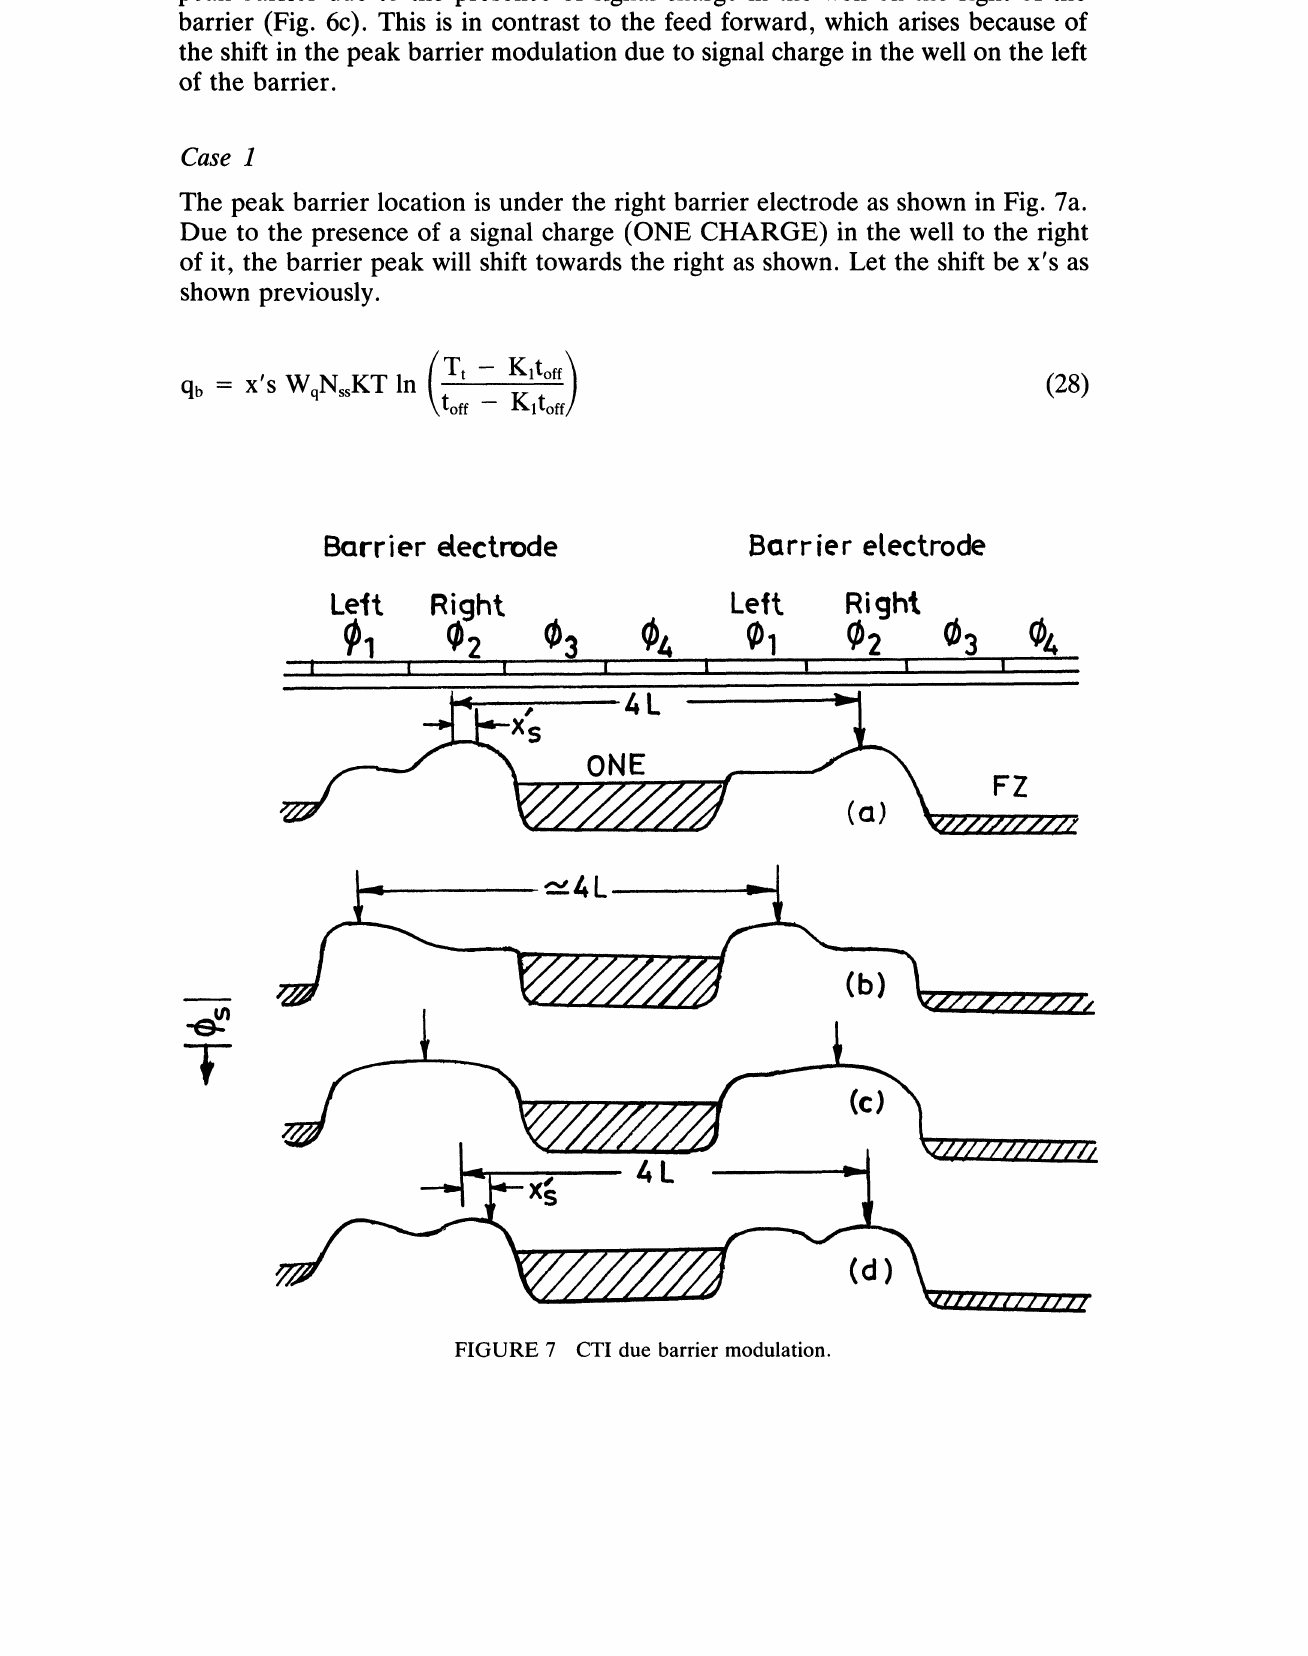
FIGURE 7 CTI due barrier